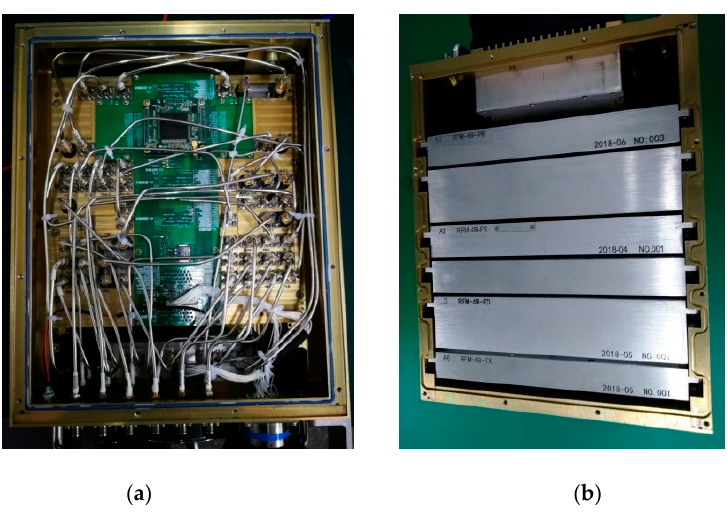
Figure 10. Outer view of the RF box: ( a ) one side; ( b ) the other side.